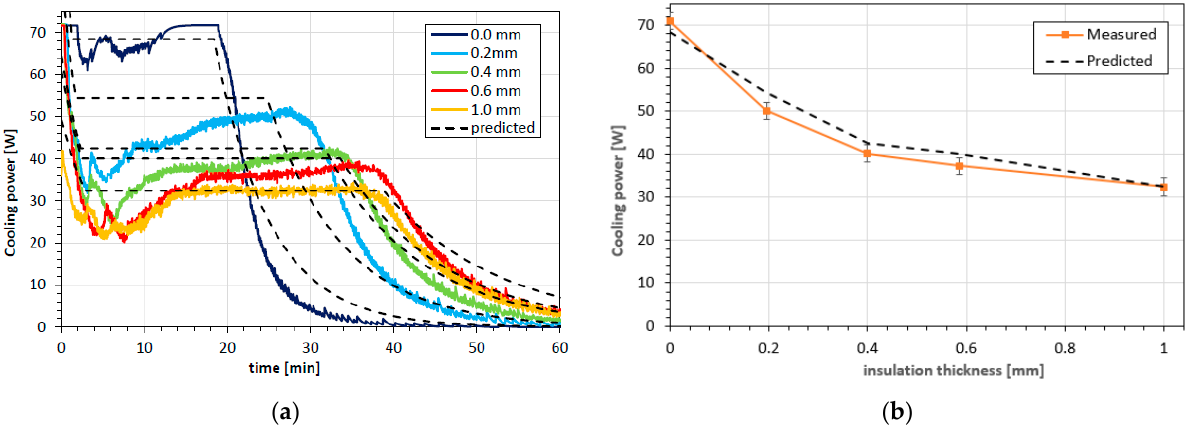
Figure 4. Measured cooling powers of ice packs on hotplate ( a ) Comparison of experiments (full lines) and predictions (dash-dotted lines); ( b ) Cooling power at melting plateau versus insulation layer thickness. Symbols: measured values, dashed line: predictions.